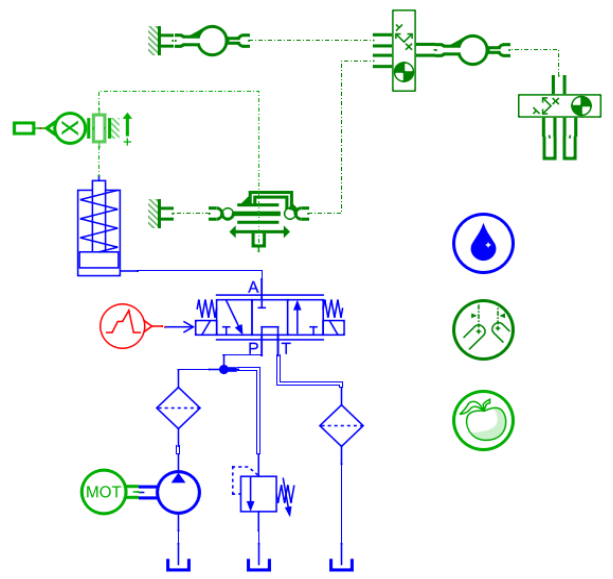
Figure 17. Software Hydraulic System Modelling.